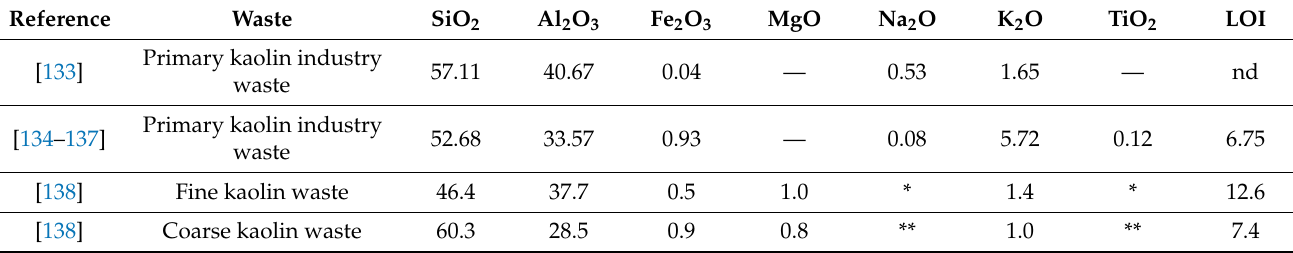
Table 15. Chemical composition (expressed wt.% oxide) of primary kaolin industry waste.